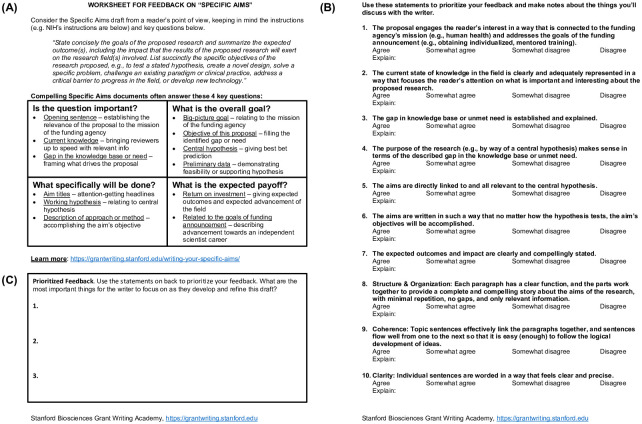
Specific aims rubric worksheet was designed to enable peers to provide prioritized feedback to the Writer.(A) Each worksheet provided strategic advice. (B) First, Readers used the back of the worksheet to rate statements that described specific aspects of the document. (C) Then, Readers prioritized their feedback.